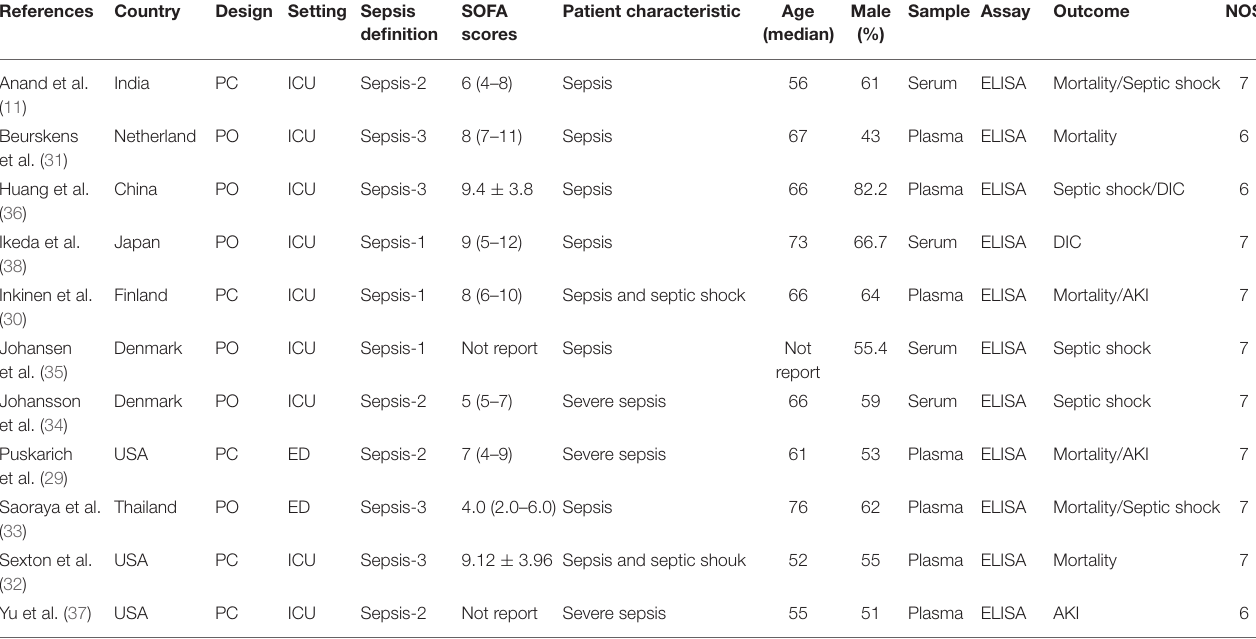
TABLE 1 | Characteristics of included